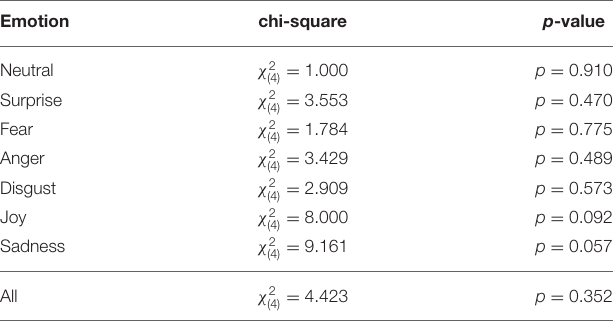
TABLE 3 | Results of the application of the Friedman Test [ χ 2 (4) ] to find differences in emotion identification per IPD on each individual